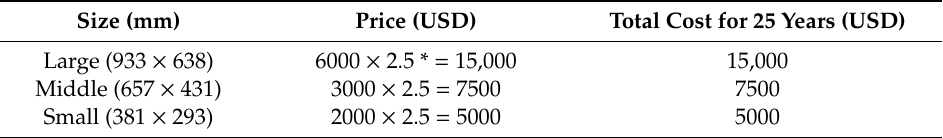
Table 9. Costs of equipment.